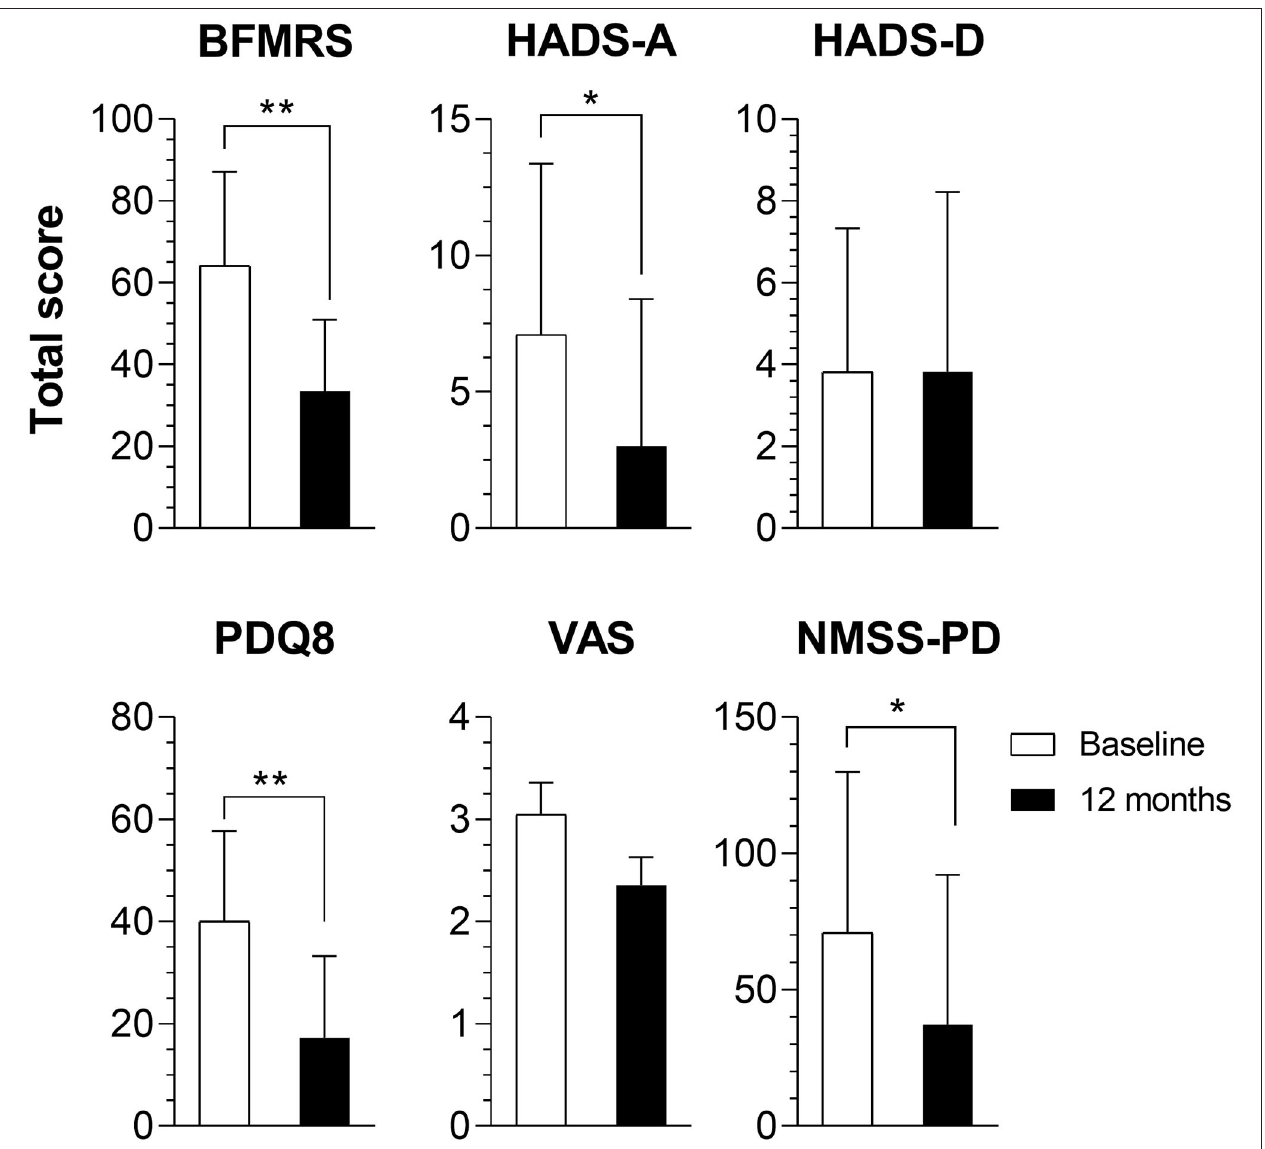
FIGURE 1 | Comparison of baseline and 1-year total scores. Results of the Burke–Fahn–Marsden Rating Scale (BFMRS), Hospital Anxiety and Depression Scale (HADS) depression (HADS-D) and anxiety (HADS-A) subscores, Parkinson’s Disease Questionnaire-8 (PDQ8), Non-Motor Symptoms Scale for Parkinson’s Disease (NMSS-PD), and Visual Analog Scale (VAS) results of all patients. * p < 0.05; ** p <